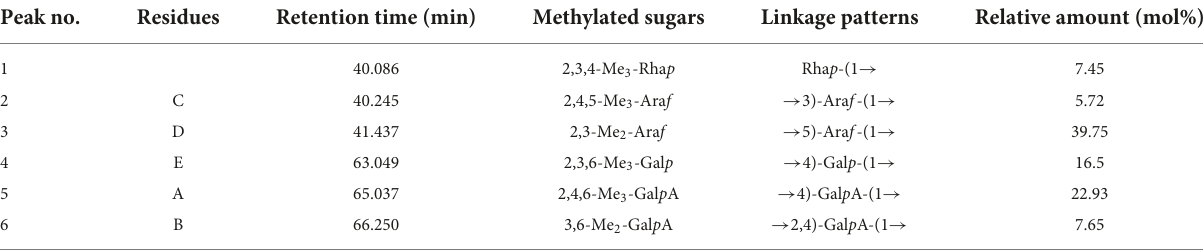
TABLE 1 PZMP3-1’s methylation analysis results. Peak no.